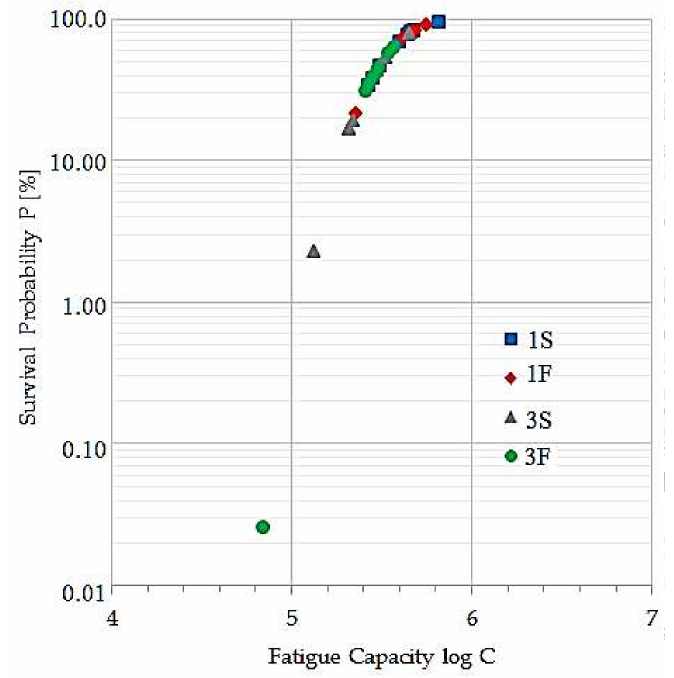
Figure 7. Survival probability for the butt welded joint specimens.